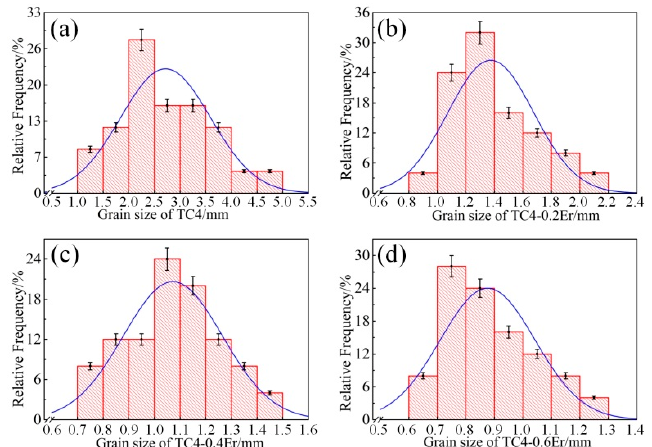
Figure 3. Size distribution of the β grains of Ti6Al4V- x Er casting alloys: ( a ) x = 0; ( b ) x = 0.2; ( c ) x = 0.4; ( d ) x = 0.6 wt %.